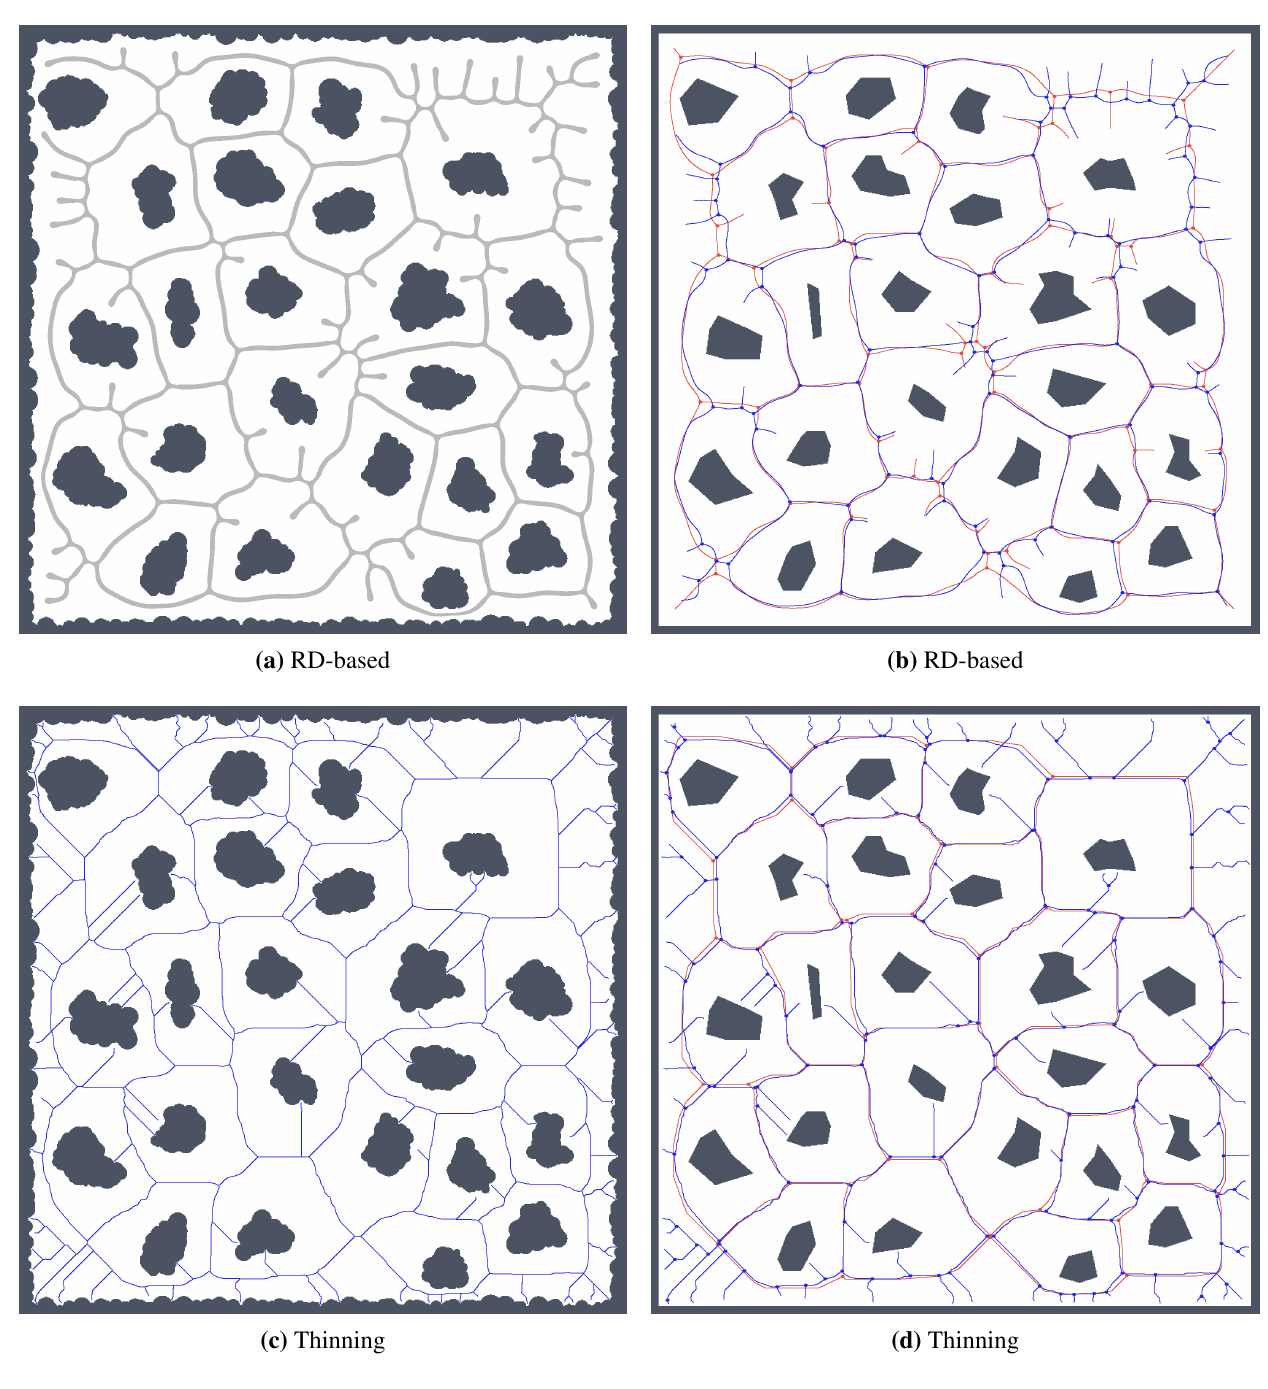
Figure 20. Determined skeletons and topological maps with highlighted junction places and leaves in the map potholes with the noise level σ = 5 for the scaled map with 1600 × 1600 grid points: ( a ) RD-based Voronoi diagram; ( b ) and its corresponding skeleton superimposed on the skeleton determined in the noise-less map (in red); ( c ) Pruned GVG representing skeleton of the map determined by the thinning algorithm [12]; ( d ) and the corresponding skeleton superimposed on the skeleton determined in the noise-less